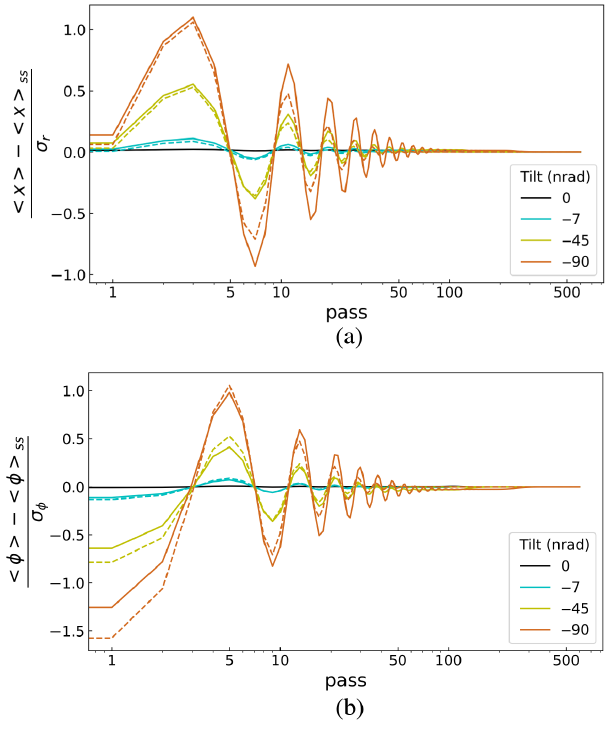
FIG. 9. Plot of (a) mean position and (b) mean divergence of the radiation beam minus their steady-state values versus pass for static misalignment cases of Fig. 5 obtained from the simulations (solid lines) and harmonic oscillator model of Eq. (32) (dashed lines). The x -axis scale is log 10